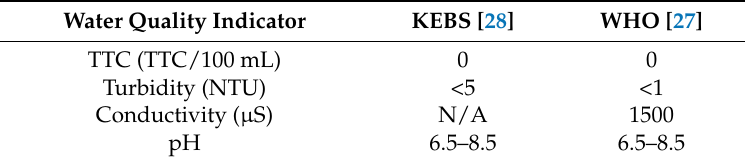
Table 1. The Kenyan Bureau of Standards and World Health Organisation Water Quality Guideline